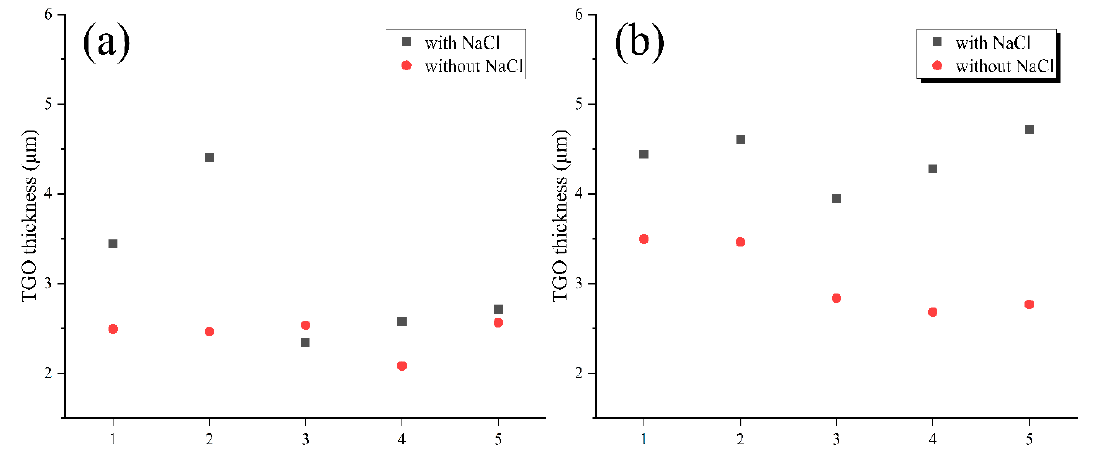
Figure 13. TGO thickness of YSZ after ( a ) four cycles and ( b ) eight cycles at five optional positions of the edge.